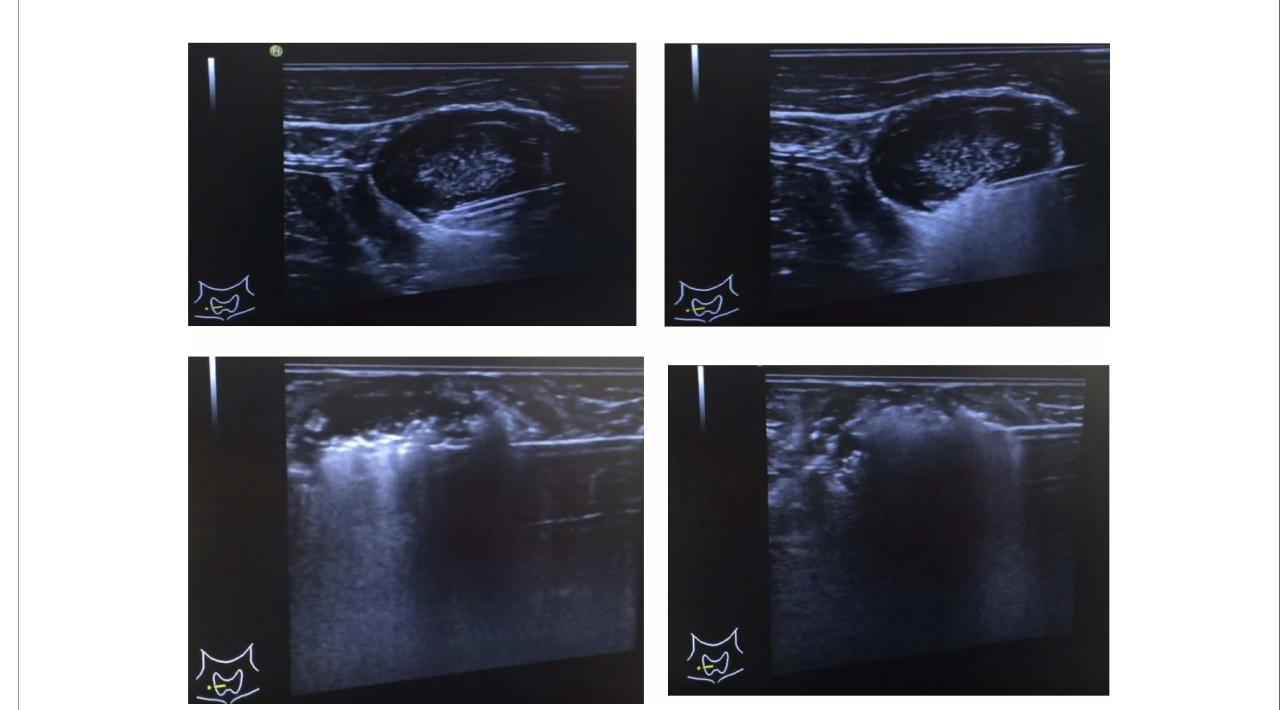
FIGURE 2 | Sequential echo-guided procedures for training the trans-isthmic approach method and the moving shot